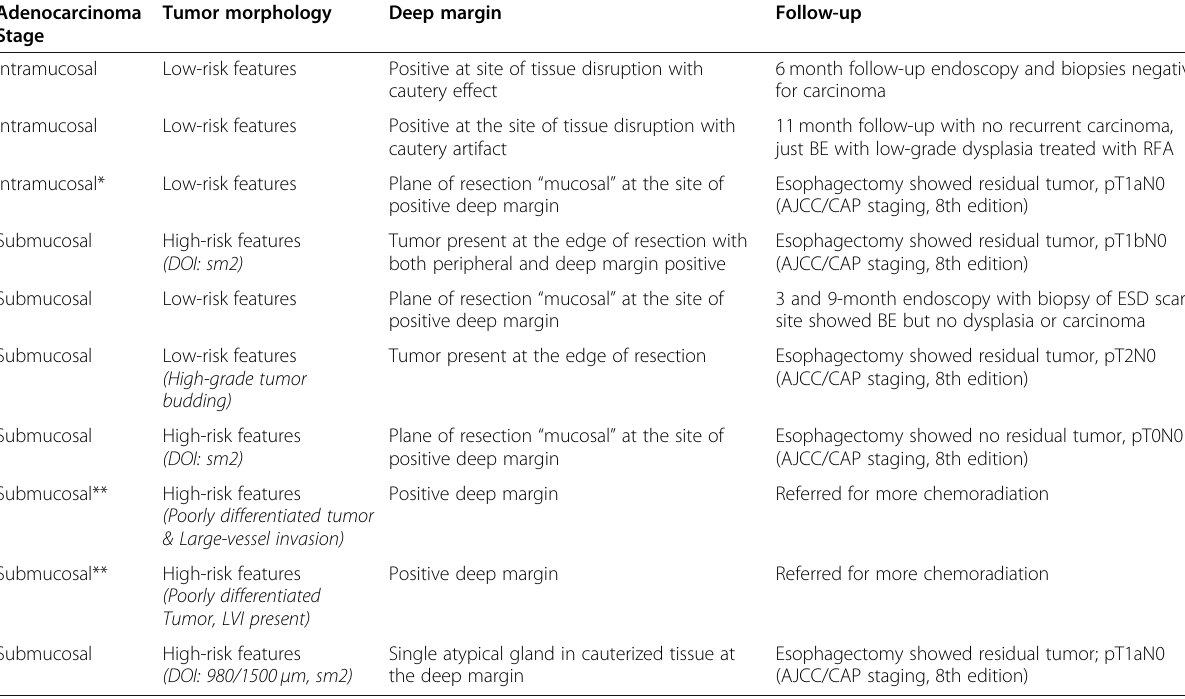
Table 4 Patients with positive deep margins ( n = 10) Adenocarcinoma